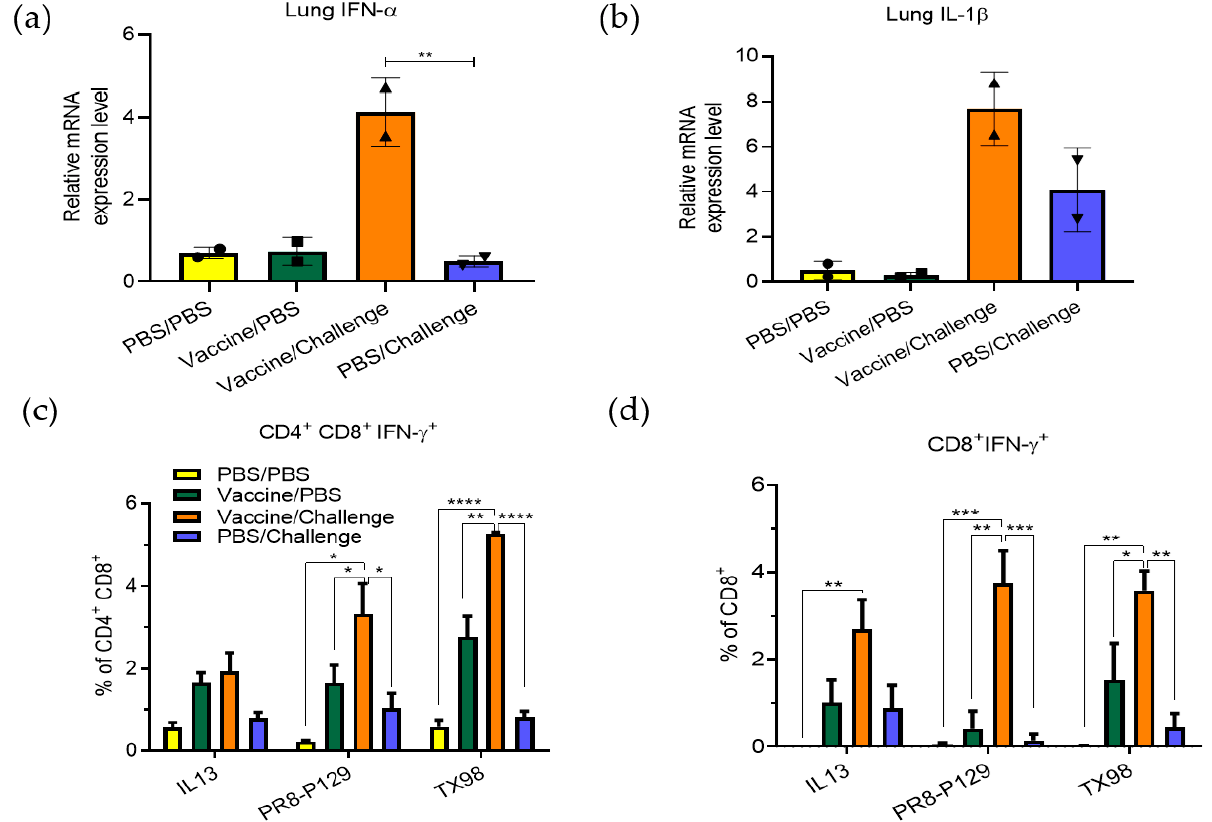
Figure 3. Innate and cellular immune responses after challenging with an influenza A virus field isolate. ( a , b ). Lung tissues collected from each group of sows at 5 DPC were subjected to cytokine RT-PCR analysis to measure the expression of IFN- α ( a ) and IL-1 β ( b ) mRNA levels. Black circle, square, up-pointing triangle, and down-pointing triangle represent samples from treatment groups of PBS/PBS, vaccine/PBS, vaccine/challenge, and PBS/challenge, respectively. ( c , d ). PBMCs collected from each group at 22 DPC were stimulated with challenge virus (IL13), PR8-P129 recombinant virus, and TX98 backbone virus. Percent IFN- γ + lymphocytes were calculated for CD4 + CD8 + and CD8 + T-cells. Statistical significance was determined by one-way ( a , b ) or two-way ( c , d ) ANOVA (Tukey’s test) and is indicated with asterisks (*, p < 0.05; **, p < 0.01; ***, p < 0.001; ****, p <